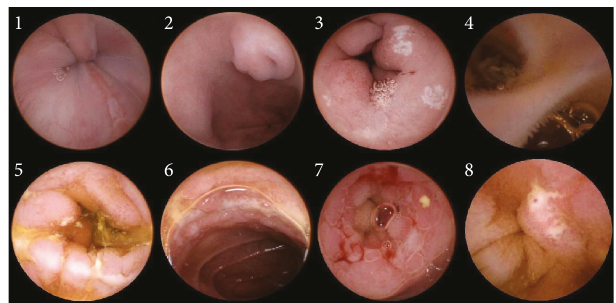
Figure 2: MGCE fi ndings. 1: re fl ux esophagitis; 2: ectopic pancreas; 3: duodenal ulcers; 4: diverticulum; 5-8: Crohn ’ s